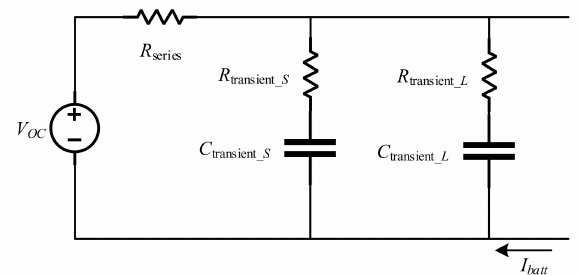
Figure 2. General equivalent circuit model (two R-C